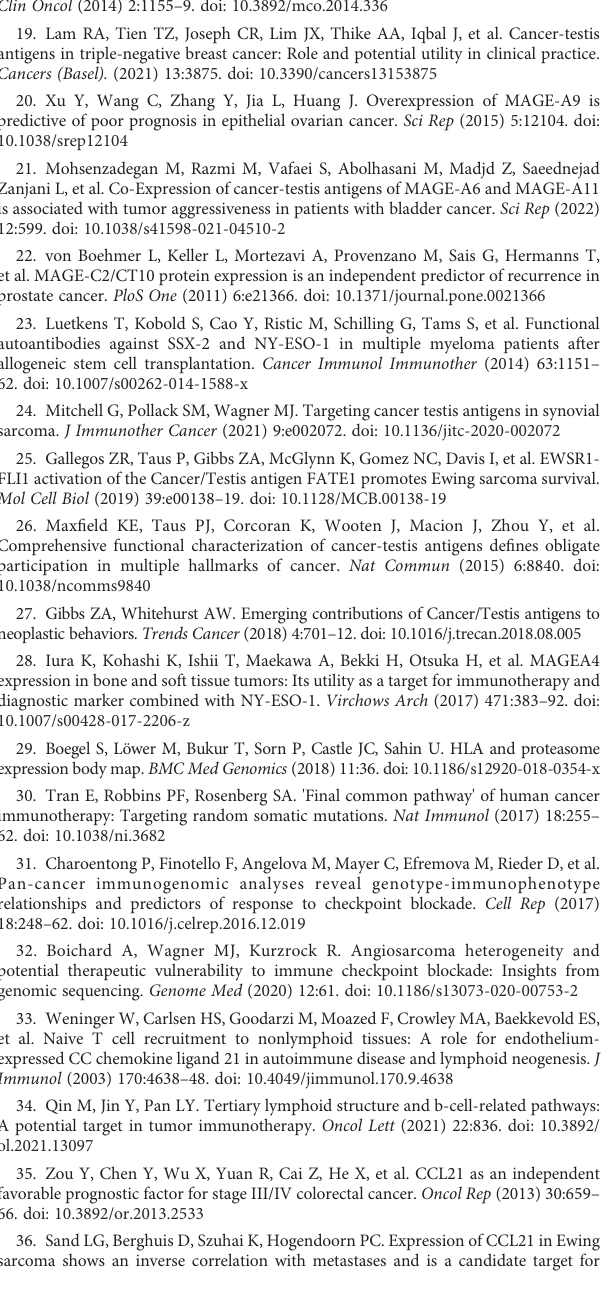
SUPPLEMENTARY TABLE 1 Characteristics, treatment, and immuno fl uorescence staining results for all